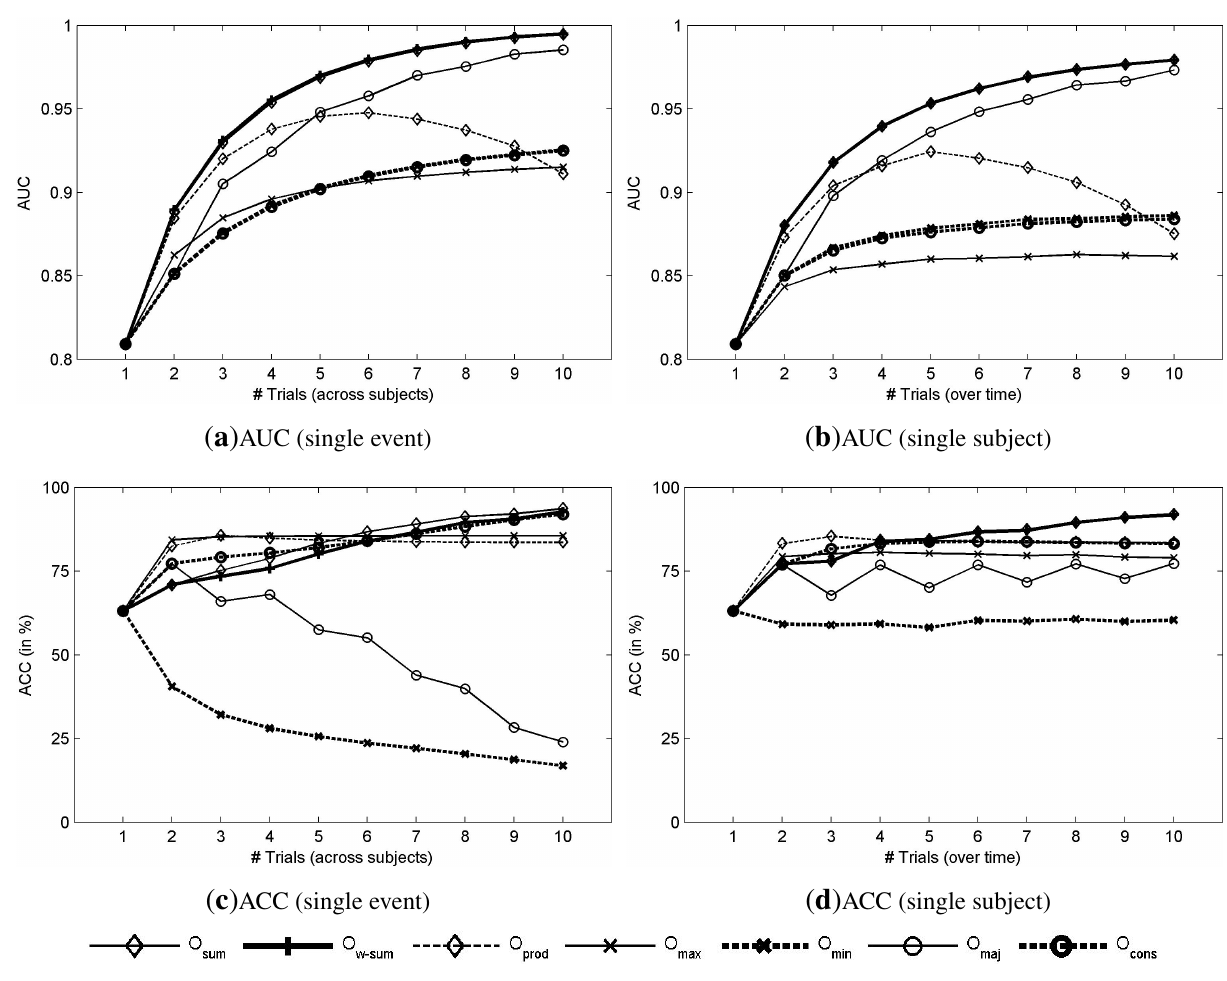
Figure 3. Detection results based on the AUC and the accuracy (ACC). ( a , b ) AUC for single-event detection as a function of the number of subjects, and AUC for a single subject as a function of the number of trials, respectively. ( c , d ) Accuracy for single-event detection as a function of the number of subjects, and accuracy for a single subject as a function of the number of trials,